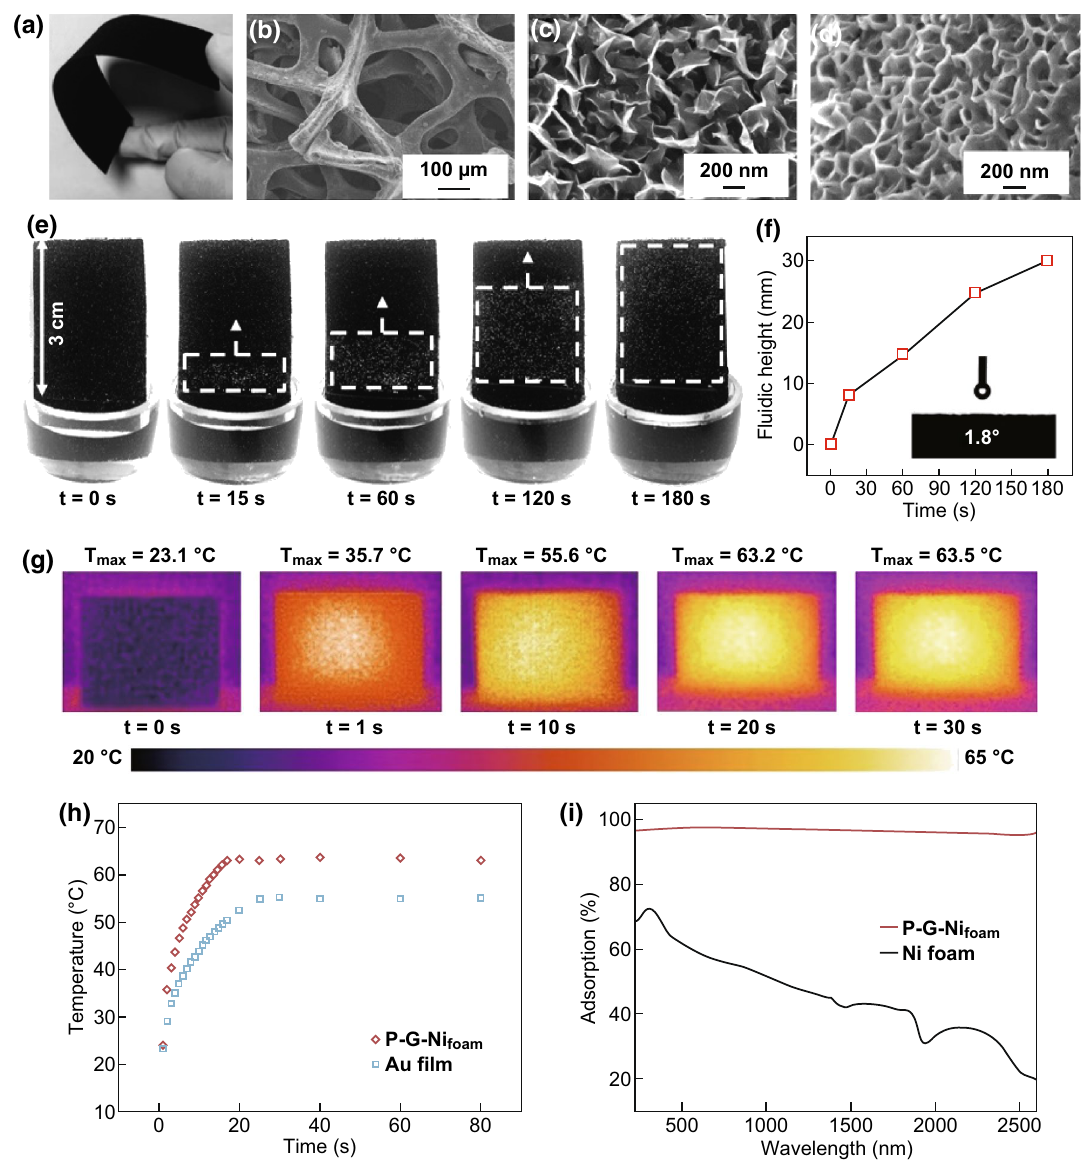
Fig. 2 Free-standing, multifunctional P–G–Ni foam layer for solar energy absorption, water transport, and solar vapour generation. a Optical image of the P–G–Ni foam . SEM image of b microporous structure of P–G–Ni foam and c , d graphene array before and after PEDOT-PSS coating. e Fluidic transport across the P–G–Ni foam in 180 s. f Flow height along with time. Inset: the static water contact angle measurement of P–G– Ni foam . g IR images of P–G–Ni foam as a function of time at an illumination of 1 kW m −2 . h Surface temperature of P–G–Ni foam as a function of time at an illumination of 1 kW m −2 . i Experimental absorption spectra of P–G–Ni foam in the wavelength range of 200–2600 nm. All tests were performed at a room temperature and atmospheric